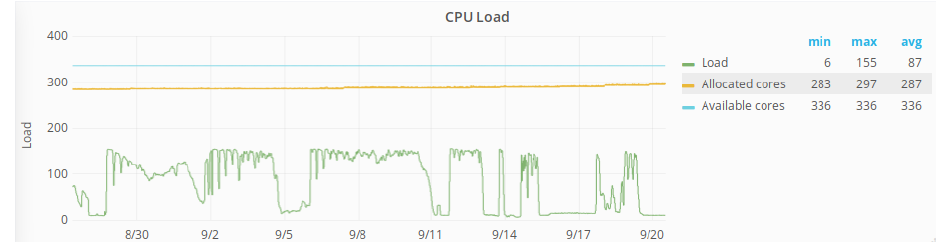
Fig. 1. CPU load in one of the JINR cloud clusters for the period of one